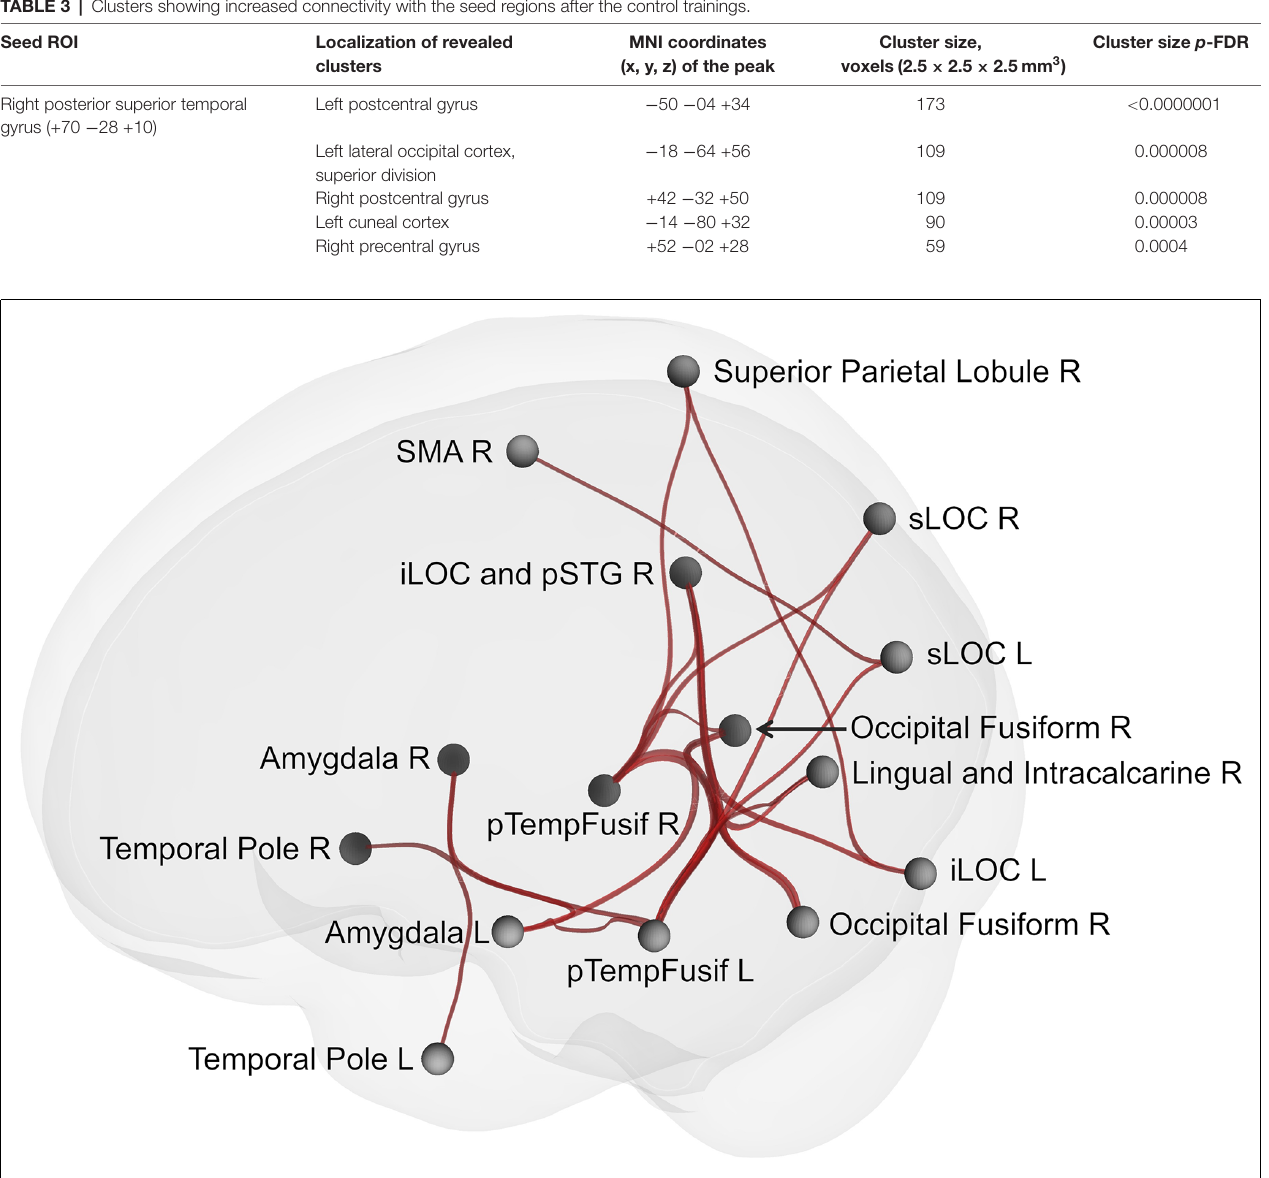
FIGURE 5 | Brain network showing increased connectivity after the course of infra-low frequency neurofeedback. The network is thresholded for the post- vs. pre- neurofeedback condition with a false discovery error rate of p < 0.001 by intensity, given a connection threshold of p < 0.01 uncorrected. iLOC, inferior lateral occipital cortex; pTempFusiform, posterior temporal fusiform cortex; sLOC, superior lateral occipital cortex; SMA, supplementary motor area; SMG, supramarginal